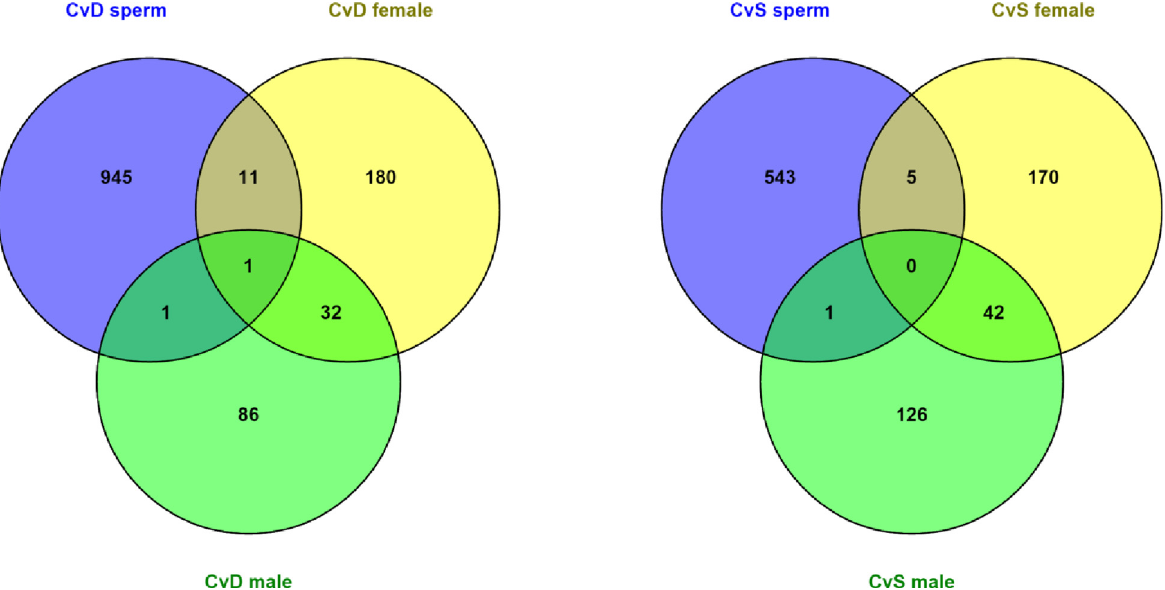
Fig 5. Overlap between differentially methylated genes in sperm and differentially expressed genes in offspring. A) CTRL v DEF comparison. Common in sperm and female offspring: Smc4, Spon2, Gpd2, Aurka, Tspan8, Tbc1d10a, Lss, Abhd2, Fdps, Hsd17b7, Dsg1c. Common in sperm and male offspring: Lrrc16a. Common in sperm and female and male offspring: Apol9b. B) CTR v SUPP comparison. Common in sperm and female offspring: 1300002K09Rik, Cyp3a16, Ethe1, Igf2, 1810011O10Rik. Common in sperm and male offspring: